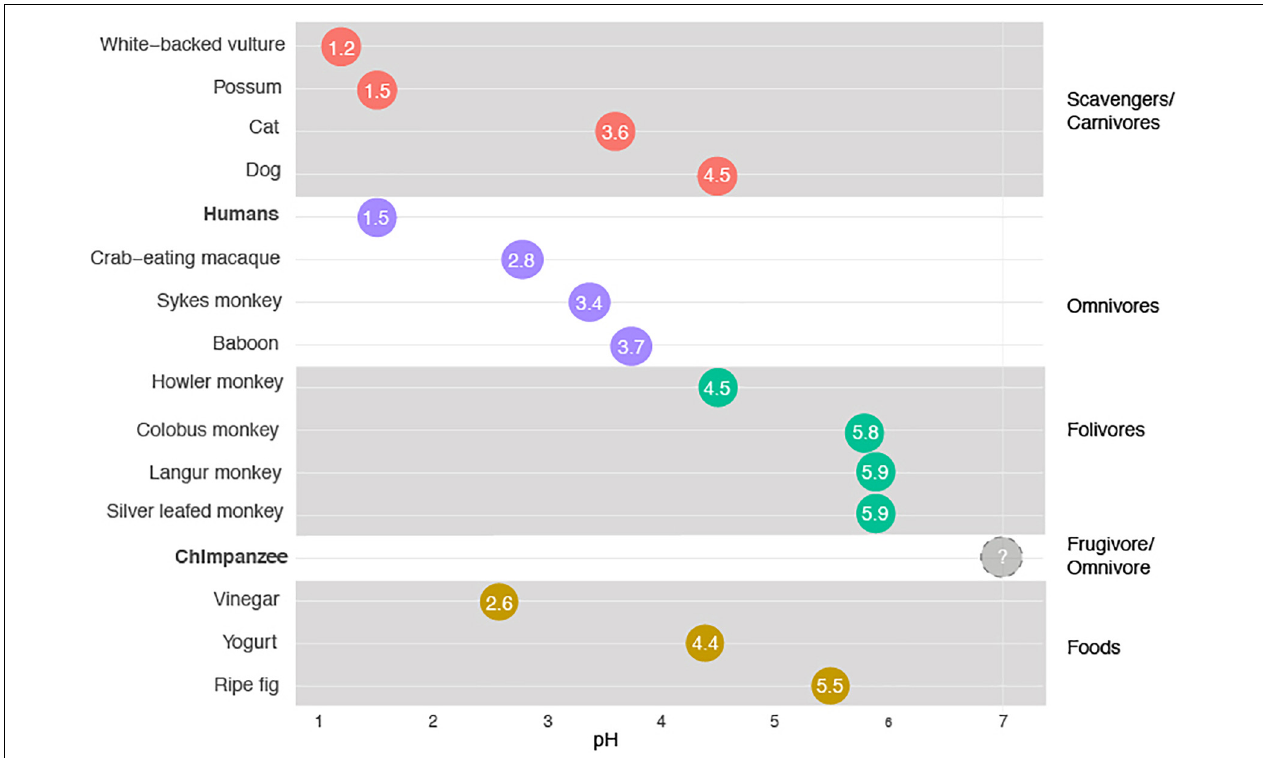
FIGURE 1 | Stomach pH as a function of animal species. A pH of 7 is neutral. Data for chimpanzees come from a single laboratory study of a single individual chimpanzee. A sampling of acidic foods eaten by modern humans is included for